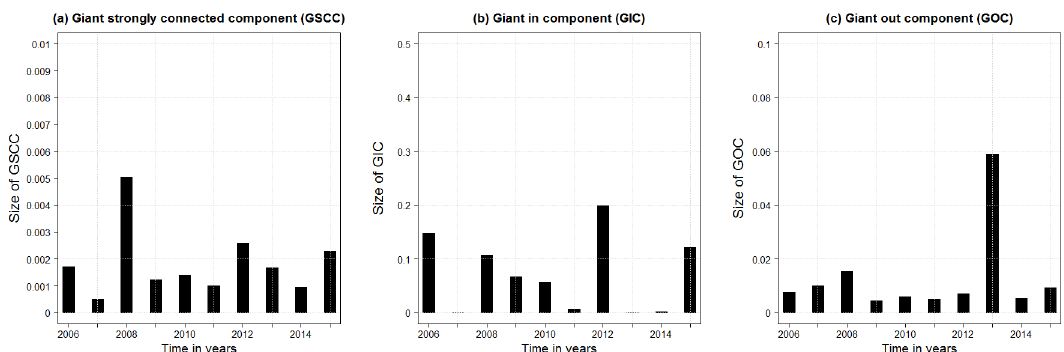
Fig 6. Pig movement network component sizes (proportion of overall number of active holdings). Sizes of (a) the giant connectedcomponents(GSCC), (b) the giant in components(GIC) and (c) the giant out components (GOC) for the yearly snapshotsof the pig movementnetwork in Denmark between2006 and